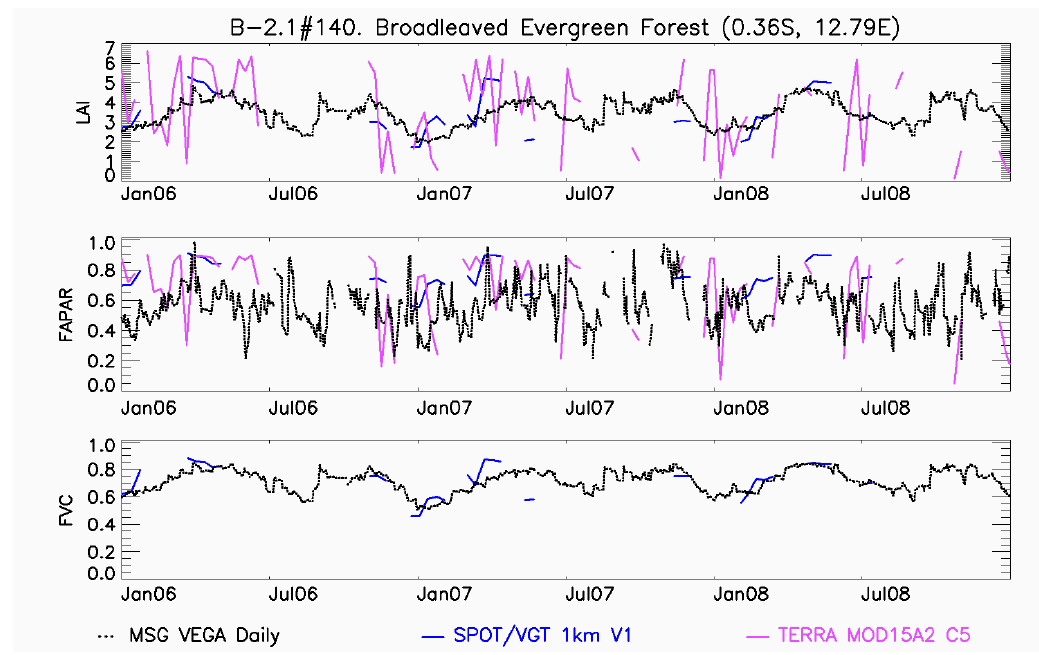
Figure 11. Comparison between LSA SAF products and equivalent MODIS and SPOT / VGT over a three-year period representative example at a site in Gabon.